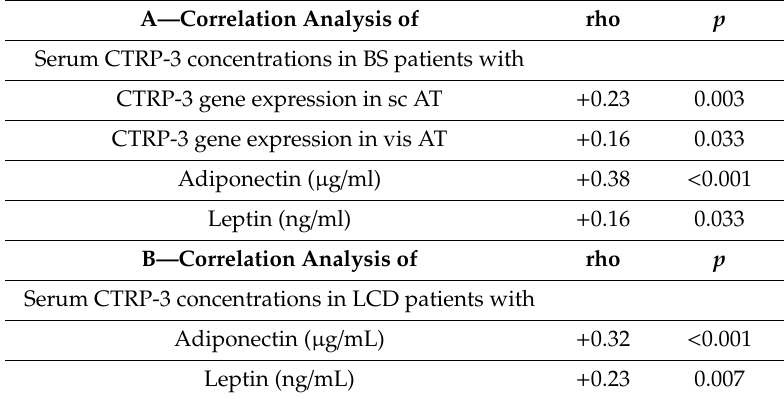
Table 1. Correlation analysis (Spearman rho test) of serum C1q / TNF-related protein-3 (CTRP-3) concentrations. ( A ) Significant correlations of basal serum CTRP-3 levels with gene expression and adipokines in severely obese patients at the time point of bariatric surgery (BS) before weight loss (asservation of subcutaneous (sc) and visceral (vis) adipose tissue) ( n = 179). ( B ) Significant correlations of basal serum CTRP-3 levels with adipokines in patients starting low calorie diet (LCD; no asservation of adipose tissue) ( n =